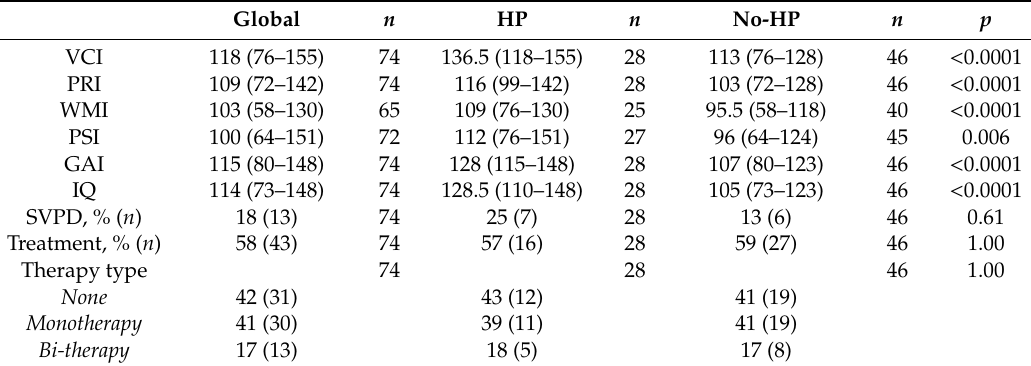
Table 5. WISC characteristics in children with and without